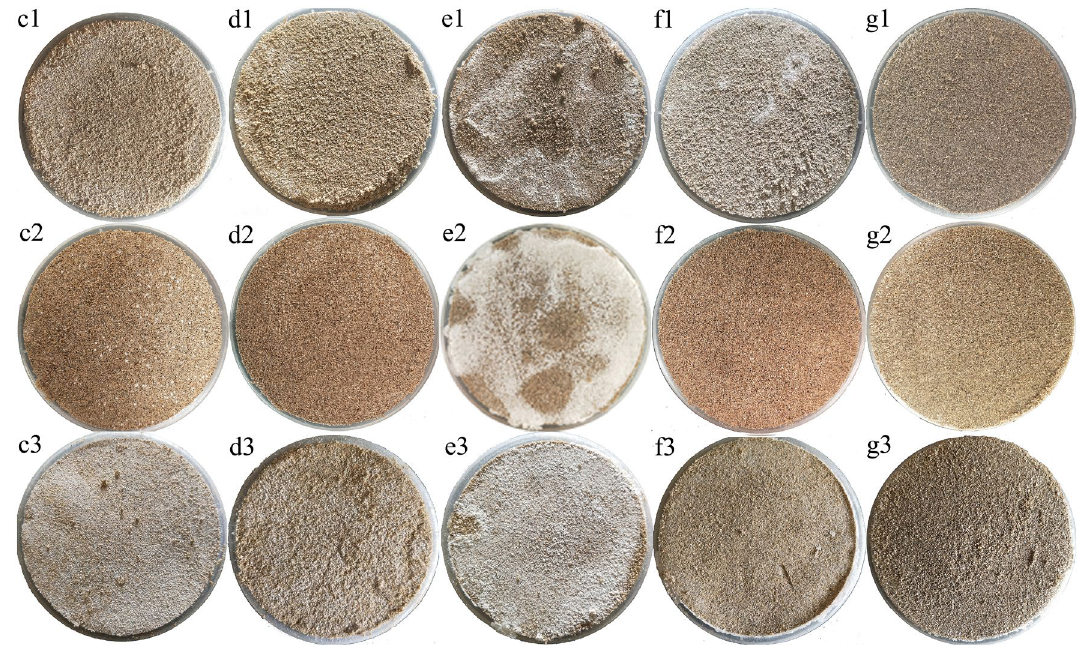
Figure 2. Crust images of salt mixtures composed of sodium sulfate and calcium chloride. Letters indicate the ratio of salt mixture, where ( c – g ) indicate salt mixture ratios (sodium sulfate:calcium chloride) of 2:8, 4:6, 5:5, 6:4 and 8:2, respectively. Numbers represent the mass percent of salt in soil, where 1, 2 and 3 represent salt mass percentages of 2%, 4% and 6%,